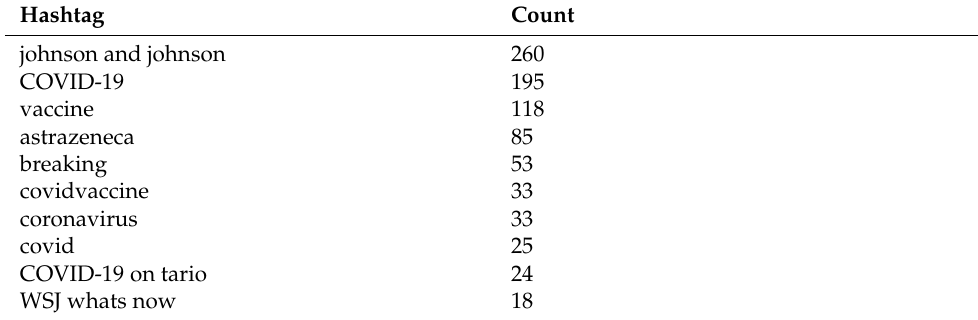
Table 2. Overview of key